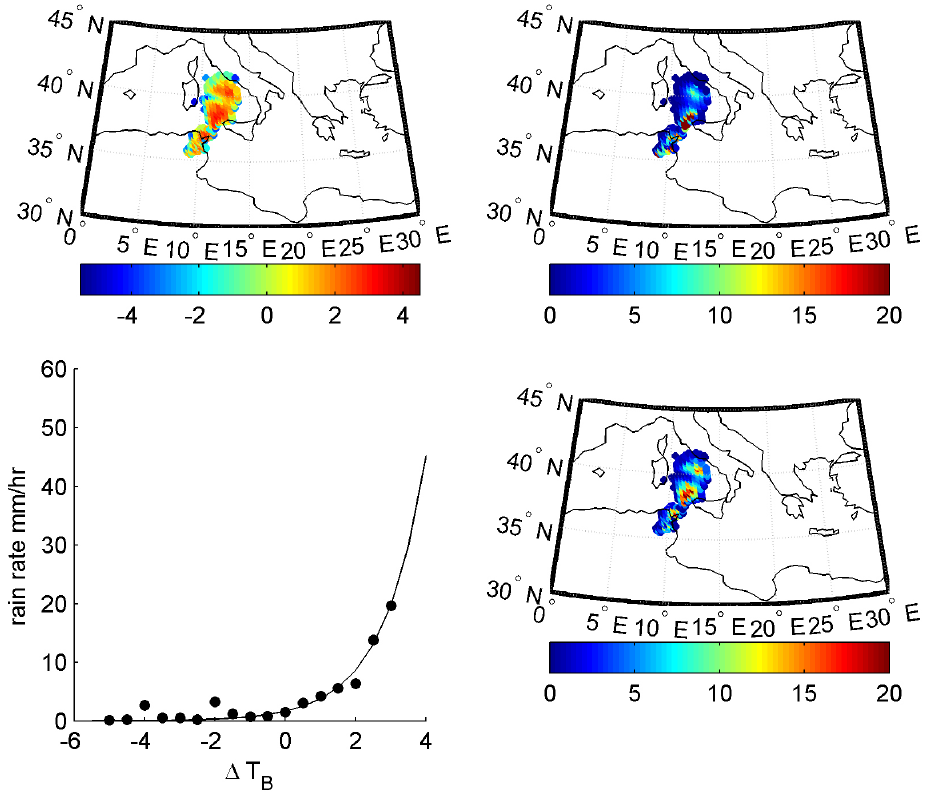
Fig. 4. Illustration of the PM-GCD calibration procedure for the selected case study. Top left panel: 1T B ’s (color scale in K) for the main cloud at 12:57UTC of 1 October 2009. Top right panel: Instantaneous rainfall rates RR (color scale in mmh − 1 ) for the same cloud, retrieved from corresponding AMSU overpass at 13:01UTC, 1 October 2009. Bottom left panel: Average ( 1T B , RR) values (dots) within 0.5K 1T B -intervals centered at 0K, ± 0.5K, ± 1K, ± 1.5K, ± 2K, etc., as derived from top panels, and corresponding calibration/fitting exponential function (solid line). Bottom right panel: PM-GCD rain rates (color scale in mmh − 1 ) for the selected cloud, computed by applying the calibration function of the bottom left panel to the T B ’s of the top left